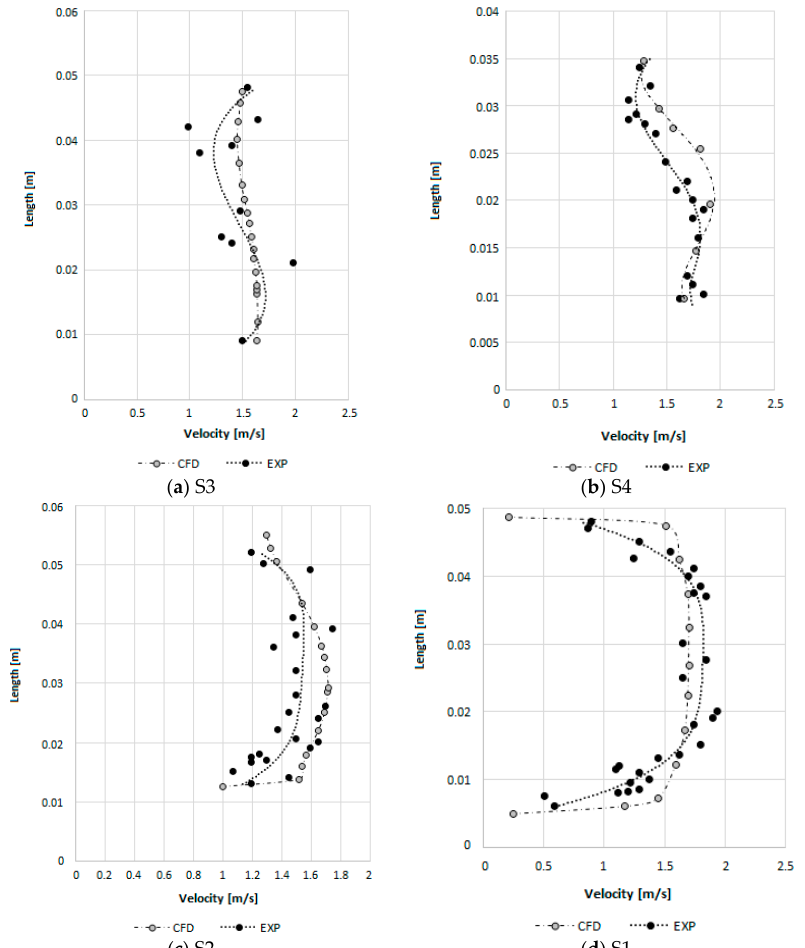
Figure 6. Velocity profiles (m/s) obtained in experimental tests and CFD simulations: ( a ) N = 520 rpm; ( b ) N = 600 rpm; ( c ) N = 680 rpm; ( d ) N = 780 rpm.